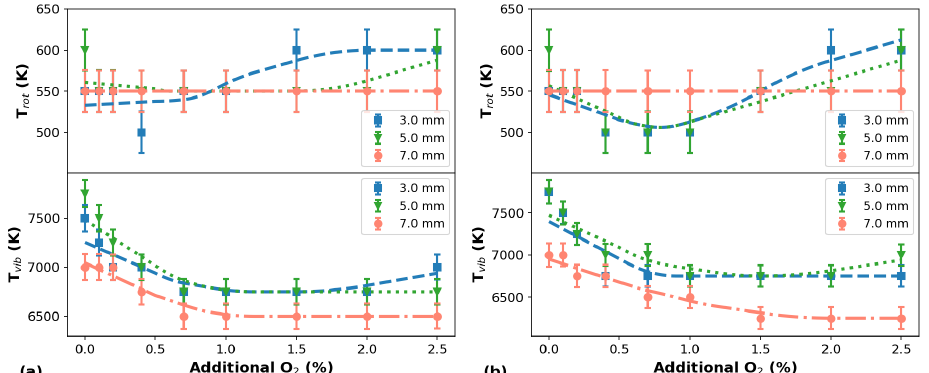
Figure 7. Variation of T rot and T vib values as a function of the additional O 2 percentage for different d values. The temperatures were measured for He flow rates of 1.5 L/min in ( a ) and 2.0 L/min in ( b ). Symbols represent experimental data and lines are trend